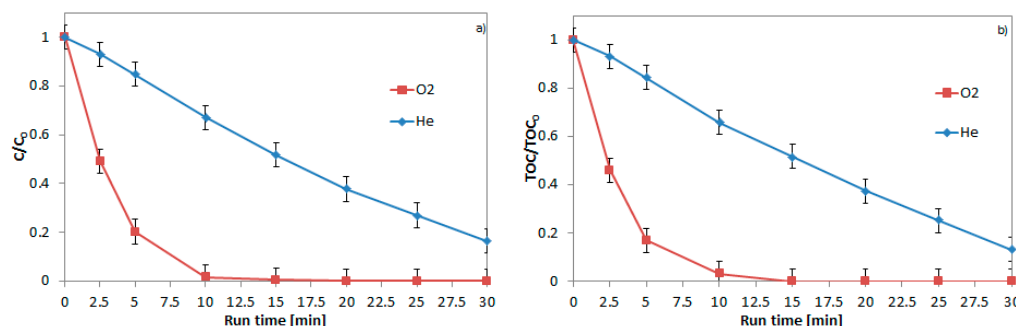
Figure 7. Influence of O 3 on AO7 discoloration ( a ) and mineralization ( b ) in a DBD reactor with SF2 catalyst. Experimental tests with (O 2 ) and without O 2 (He). AO7 initial concentration: 20 mg/L. Applied voltage: 12 kV. O 2 flow rate: 0.18 NL/min.